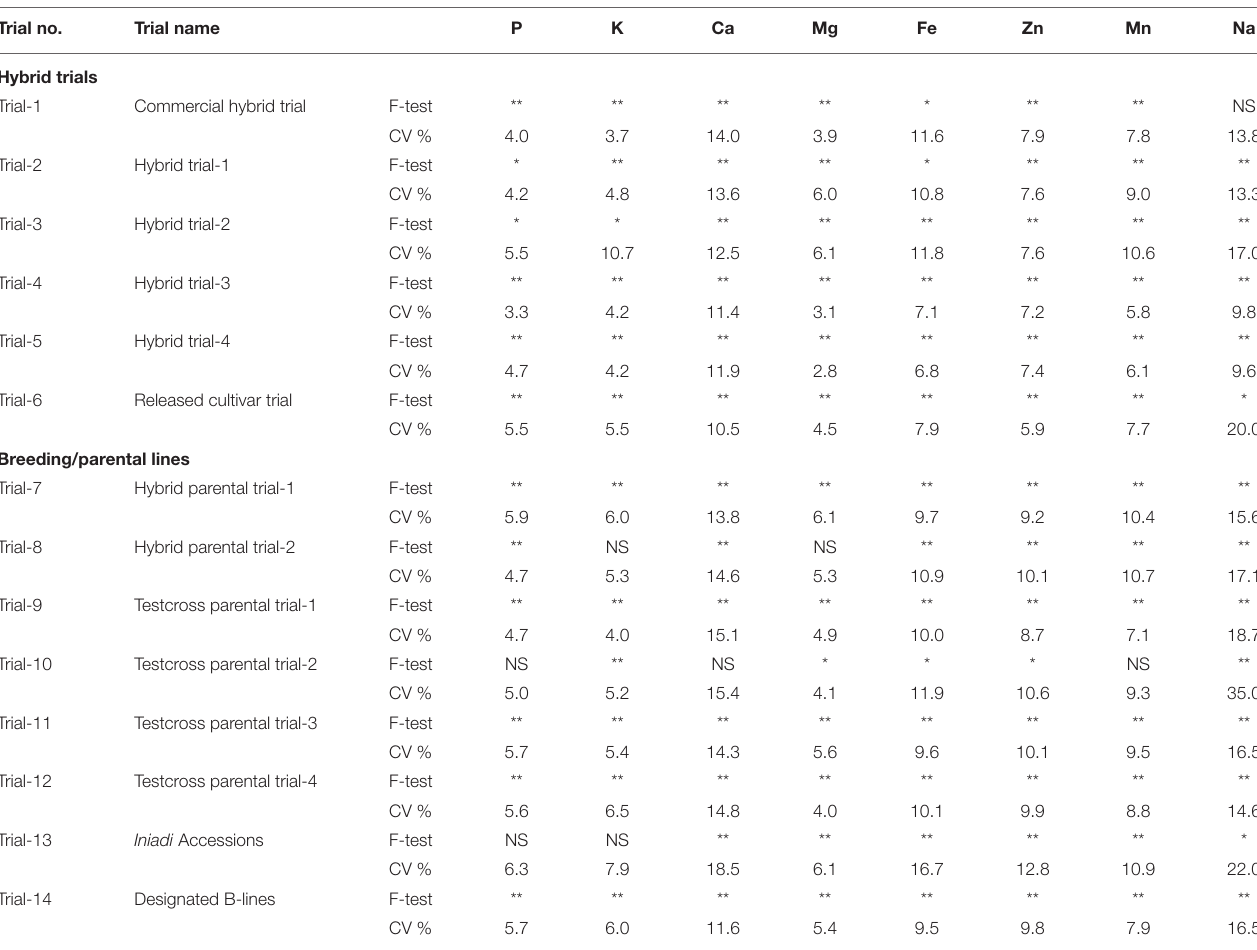
TABLE 2 | Analysis of variance for macronutrient and micronutrient contents in pearl millet breeding trials at ICRISAT, Hyderabad, India. Trial